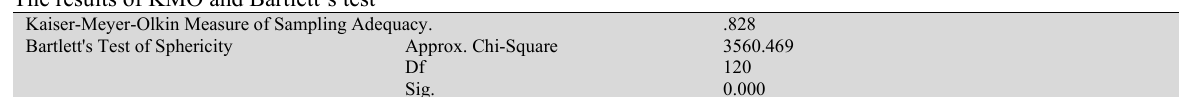
The results of total variance explained